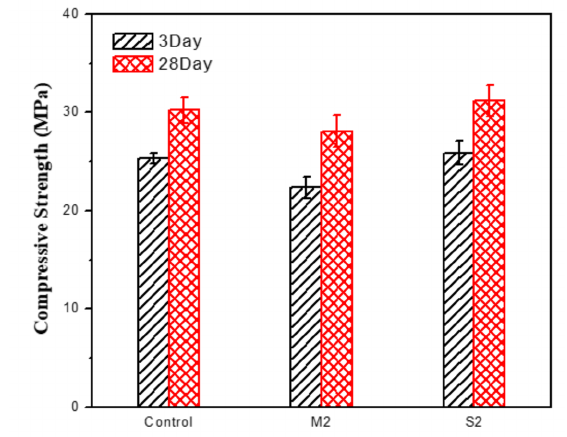
Figure 10. Compressive strength of Control, M2 and S2 at 7 days and 28